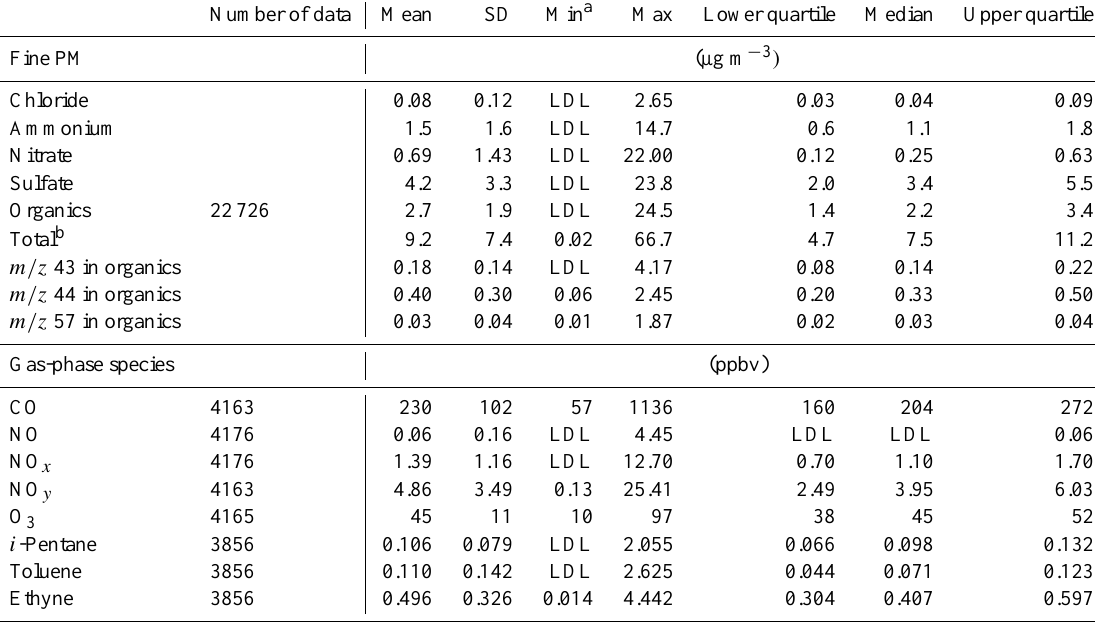
Table 1. Concentrations and mixing ratios of chemical species observed during the study period. Number of data Mean SD Lower